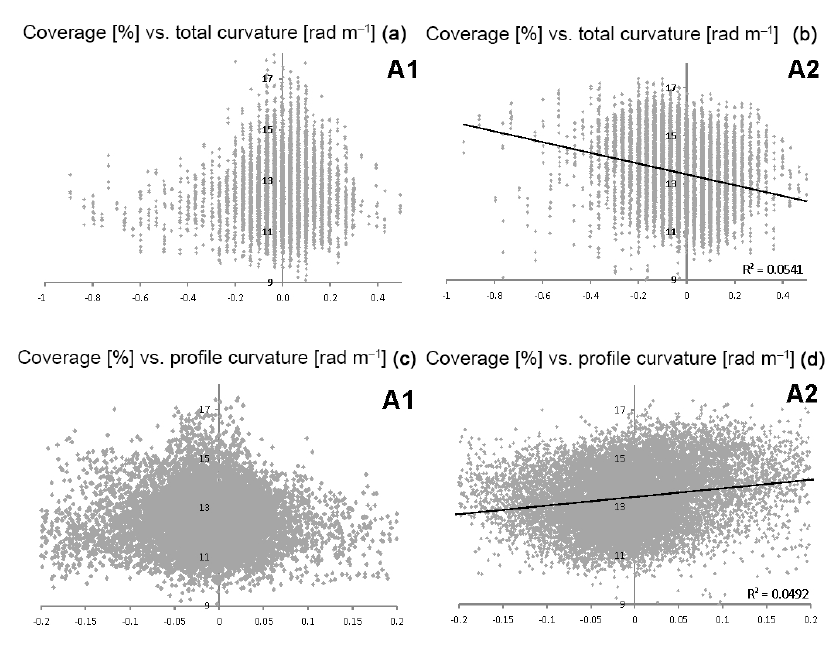
Figure A2. Scatterplots indicating the relation between Mn-nodule coverage and total curvature (a, b) and profile curvature (c, d) in the A1 and A2 sub-areas. Only in area A2 weak correlations could be